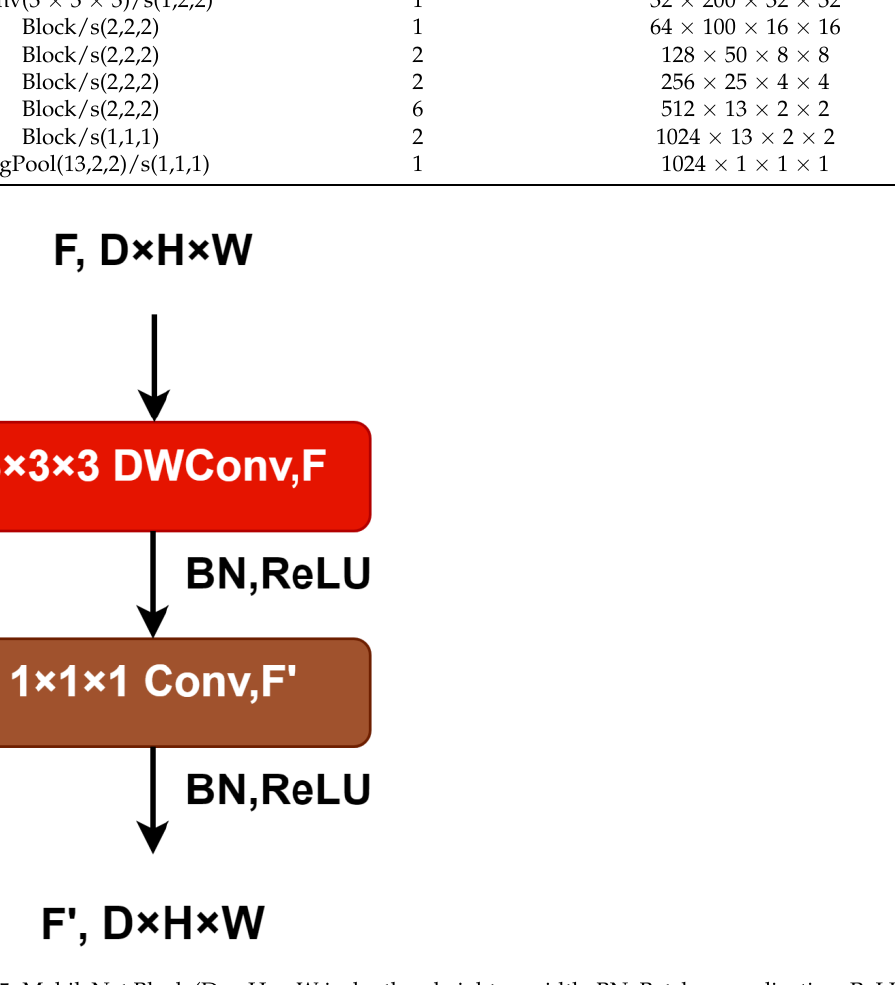
Figure 5. MobileNet Block (D × H × W is depth × height × width, BN: Batch normalization, ReLU: Rectified Liner Unit activation function). Table 2. Properties of layers following the 3D MobileNet base model.